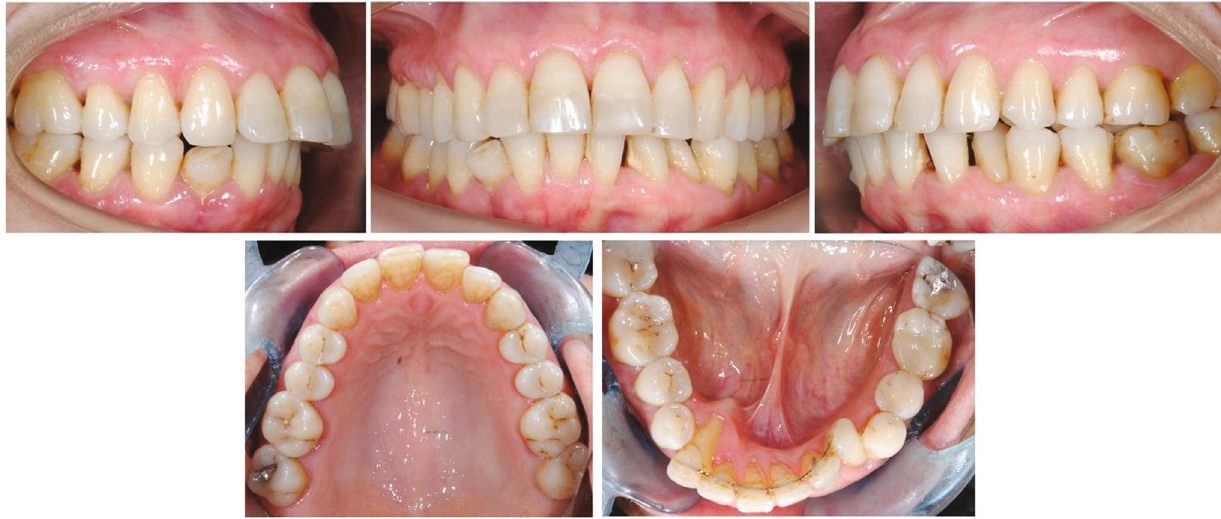
Figure 1: Initial intraoral